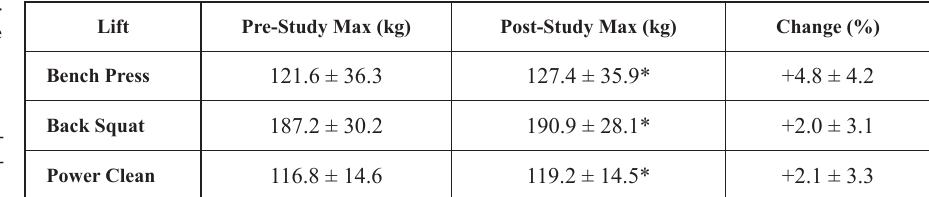
Table 3. Performance re- sponses of main resistance exercise lifts (mean ± SD)